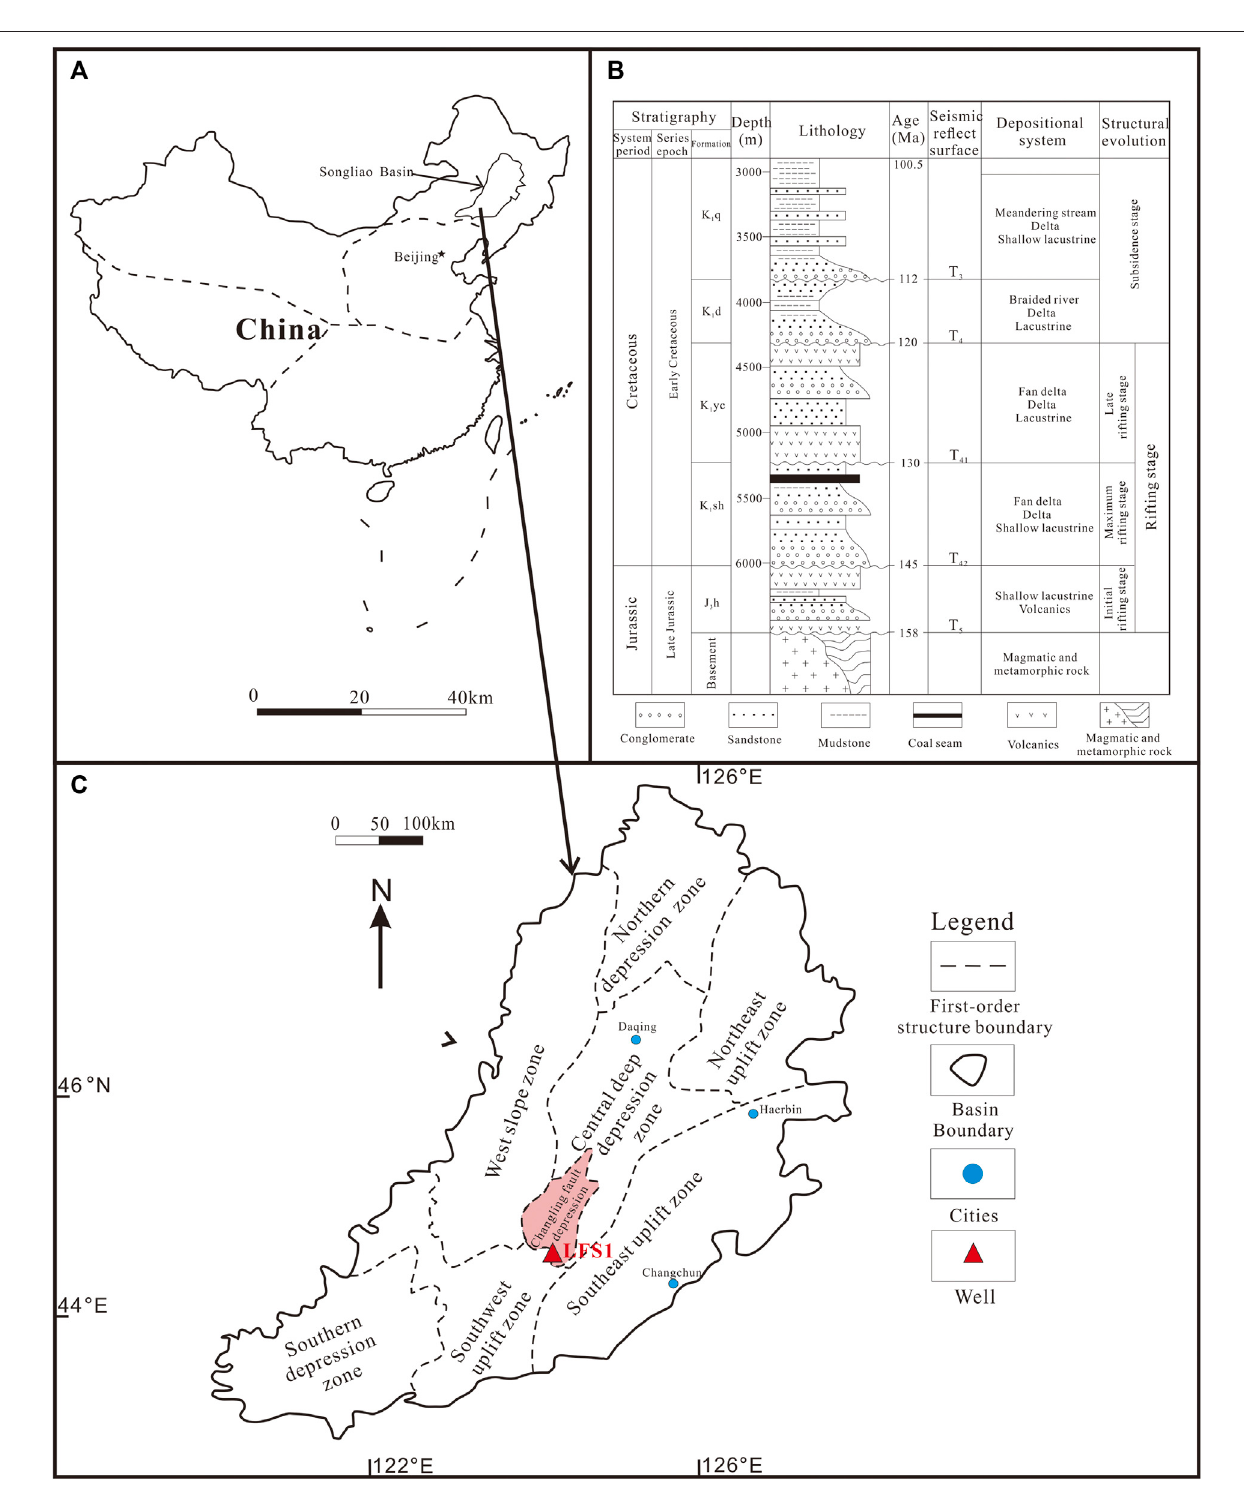
FIGURE 1| (A) Location ofthe Songliao Basin within China. (B) Stratigraphic column of the Changling Fault Depression. J 3 h, Huoshiling Formation; K 1 sh, Shahezi Formation; K 1 yc, Yingcheng Formation; K 1 d, Denglouku Formation; and K 1 q, Quantou Formation (modi fi ed after Cai et al., 2017). (C) Location of the Changling Fault Depression and sampling well (modi fi ed from Wang M. et al., 2015).